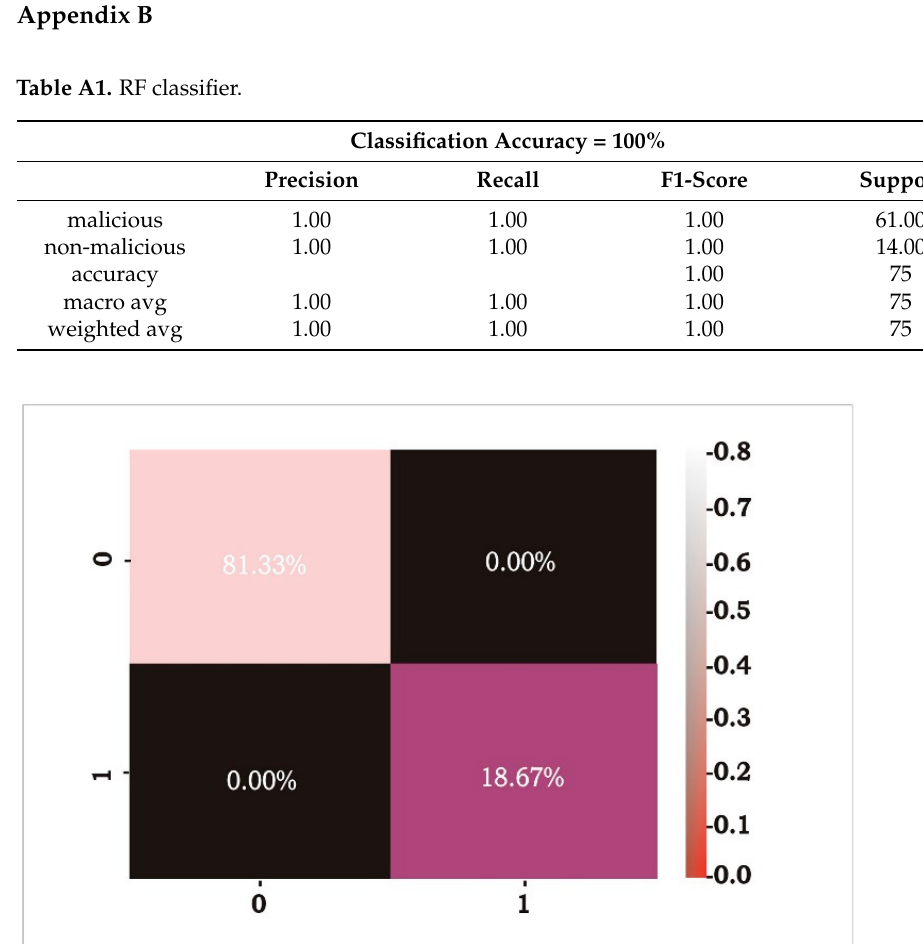
Figure A2. RF classifier model summary with a confusion matrix.